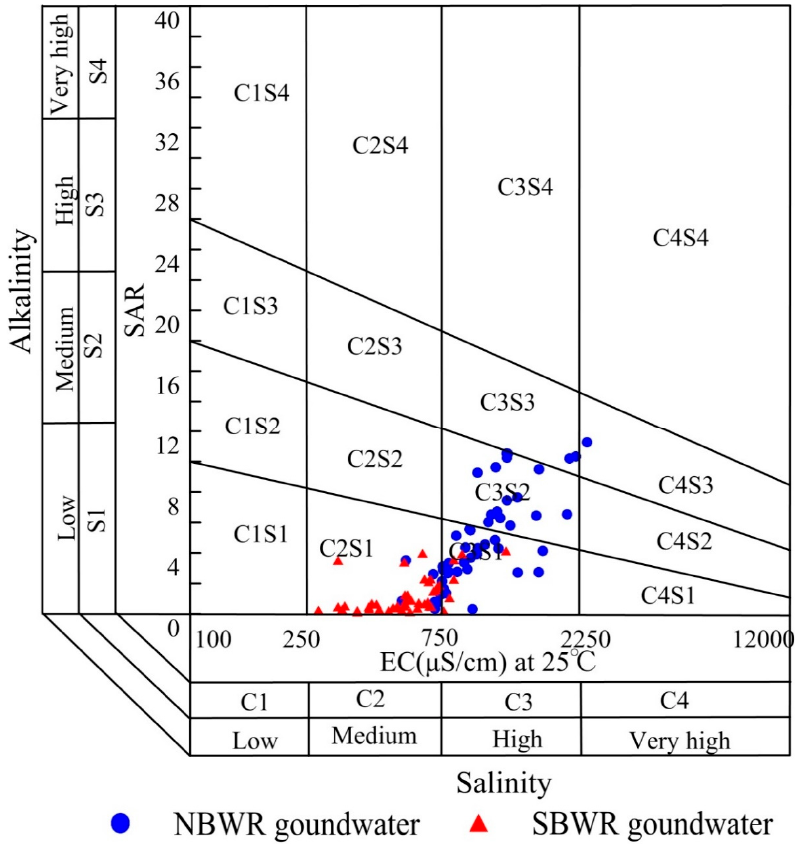
Figure 5. Wilcox diagram for irrigation water quality assessment.